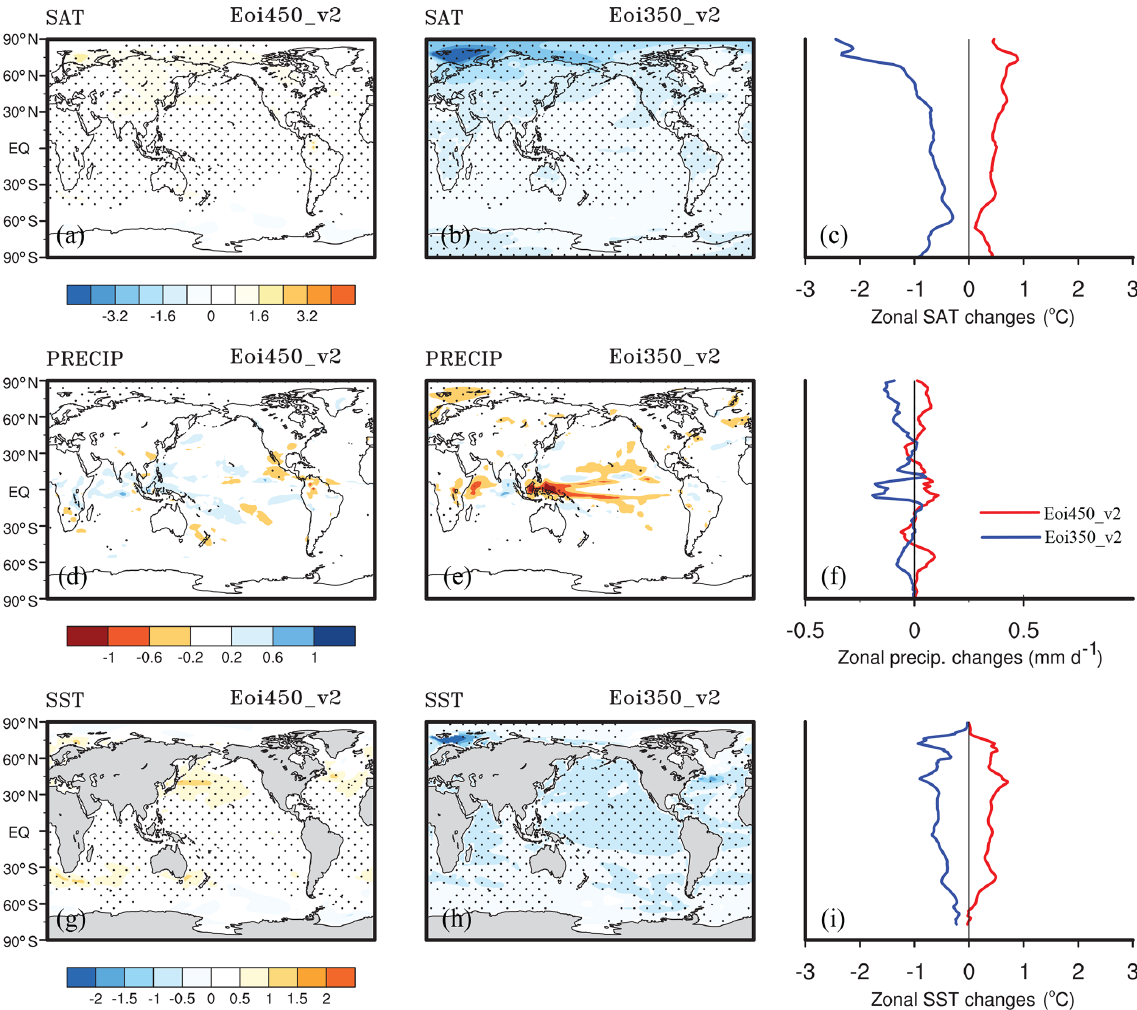
Figure 11. Anomalies of mean annual SAT, mean annual precipitation rate, and mean annual SST for Eoi450_v2 ( a , d , g ) and Eoi350_v2 ( b , e , h ) in comparison with Eoi400_v2. The last column ( c , f , i ) of this panel shows the zonal mean of related anomalies (red and blue lines, respectively, represent the results of Eoi450_v2 and Eoi350_v2). Stippling indicates regions where results are statistically significant at 99% confidence